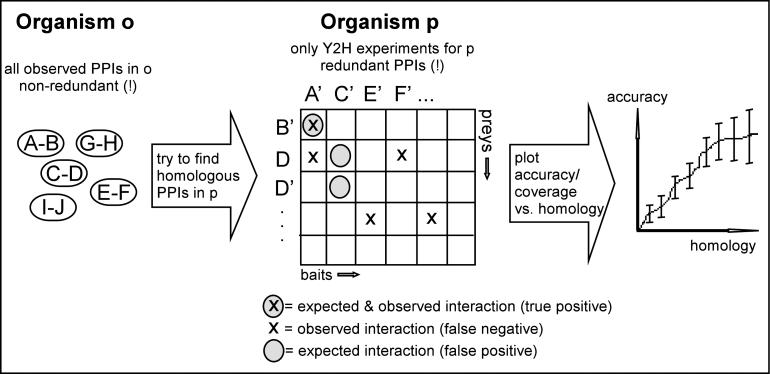
Evaluating Homology Inference of PPIsStarting with the entirety of observed interactions in any organism o (Y2H plus small scale experiments), we first reduce the sequence redundancy from this dataset as described in Figure 3. Then we try to find homologs in the organism p for each of the unique PPIs of organism o. Since we want to be able to conclude that every nondetected interaction in organism p does actually not exist in real life, we need to have a complete interaction matrix (baits × preys) for organism p. Thus, we are forced to exclude all small-scale data from the organism p dataset and remain with a merger of all (redundant) Y2H interactions for this organism. For each interaction A-B from organism o, we can face any of the following situations: (a) A homologous interaction A′-B′ can be found in organism p, (b) no homologous interaction can be found in p, or (c) It is impossible to detect an interaction of type A′-B′ in p because of one of the following two reasons: (i) either A′ or B′ are missing in the dataset for p or (ii) Both A′ and B′ are either preys or both are baits in the dataset for organism p. The latter case (c.ii) is illustrated by the interaction E-F in organism o, which cannot be detected in organism p only because E′ and F′ are both used as preys in the experiment. No counts for false positives are made for those cases. Adding the numbers of true positives (expected and observed PPIs), false positives (expected but not observed) and false negatives (observed interaction only in organism p) allows us to calculate accuracy and coverage for each homology threshold used to infer interactions (Equation 4). It is important to note that in the case where o = p, comparisons between two identical experimental PPI-sets are ignored (e.g. A-B in o′s set “yeast-Ito-2001” is not used to predict A′-B′ in p′s set “yeast-Ito-2001”; o = p = yeast).